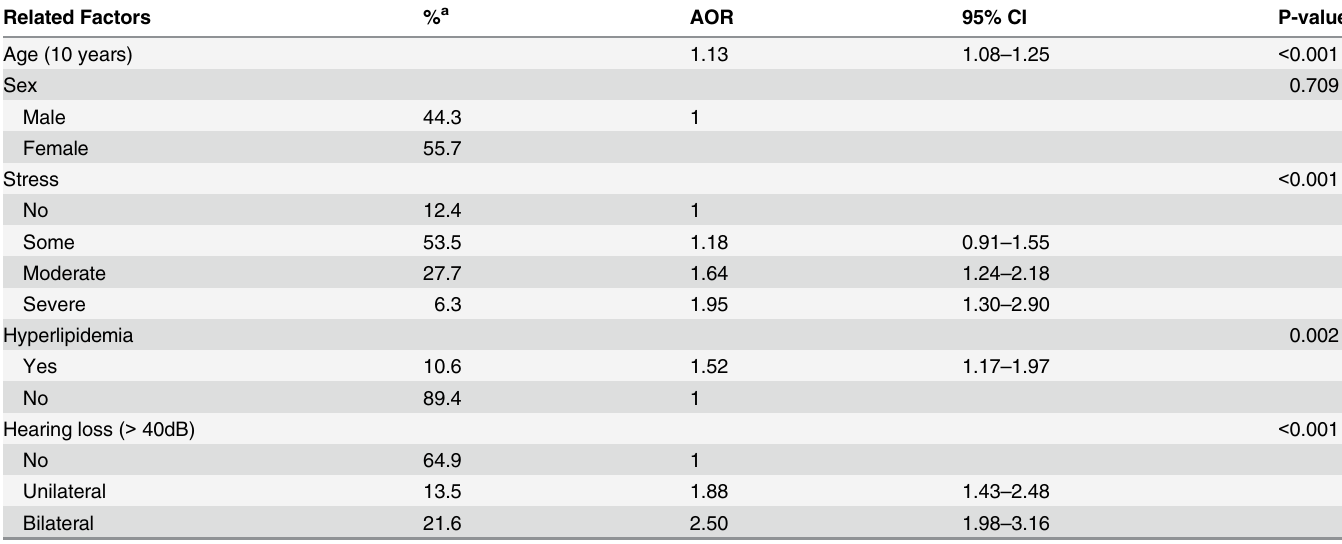
Table 4. Multiple logistic regression analysis with complex sampling for tinnitus